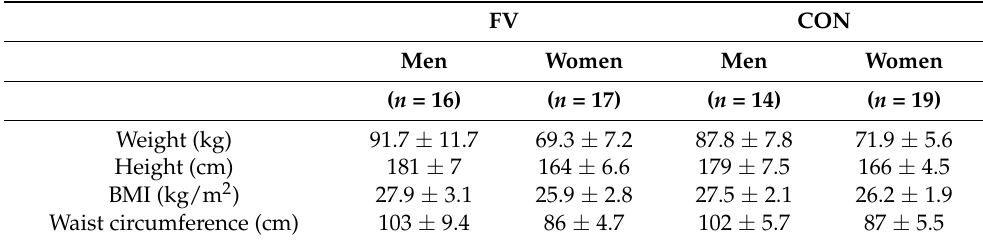
Table 1. Subject characteristics in the fruit and vegetable (FV) and control (CON) groups. FV CON Men